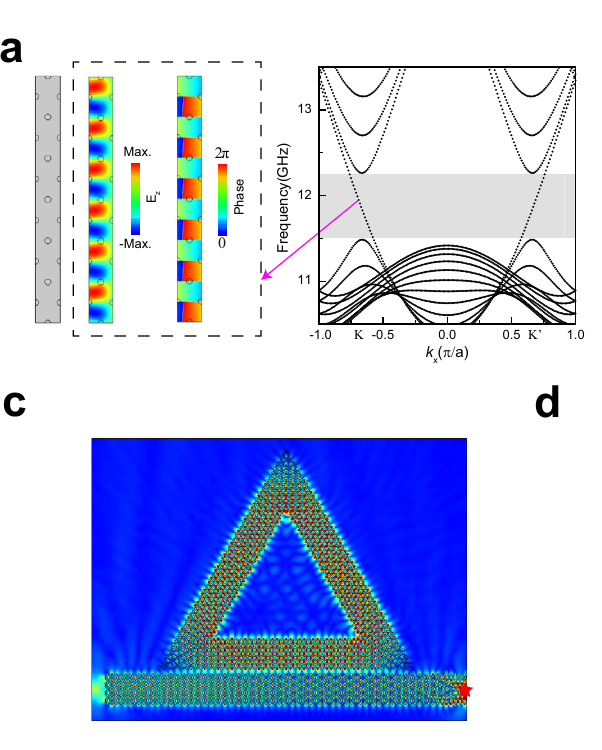
Fig. 6 | Triangular waveguide resonator based on CABSs. a Photonic crystal waveguide (microwave frequencies) bounded by perfect electrical conductor boundaries above and below and periodic boundaries on the left and right. Right panel: band dispersion of the photonic crystal waveguide and the corresponding electric fi eld (colors) and the phase (colors) fi eld of a CABS in the pseudogap (shadowed region). b Simulated electric fi eld distributions at11.9GHz excited by a point source (red star) on the right of the 120-degree-bend waveguide. Right